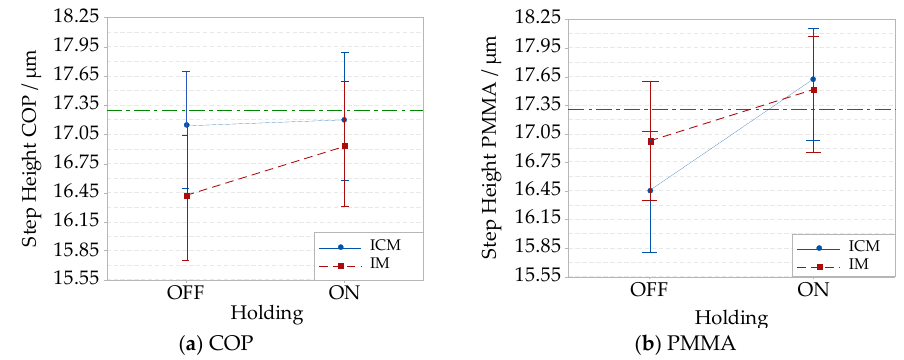
Figure 6. Interaction plots showing the replication of absolute dimensions of the Fresnel lens’ grooves with a nominal step height of 17.3 µm. A measurement uncertainty is added to the results obtained for IM without the holding pressure, IM with holding pressure, ICM without holding pressure, and ICM with holding pressure: ( a ) COP material; ( b ) PMMA material.